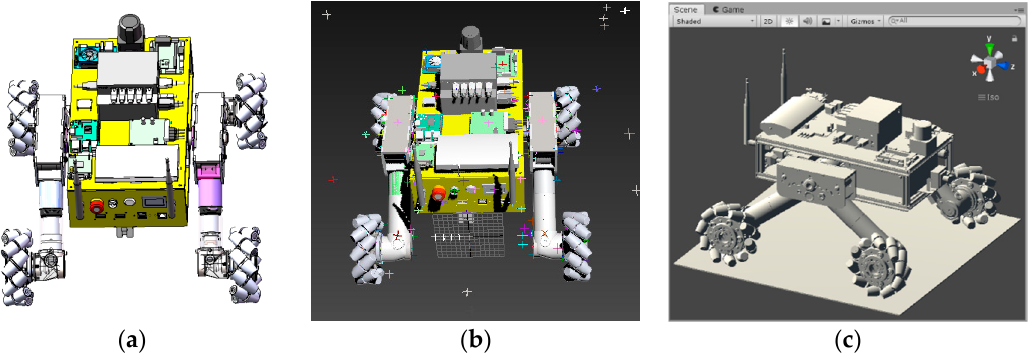
Figure 24. Three-dimensional model of the robot imported from SolidWorks into Unity3D: ( a ) 3D model built in SolidWorks; ( b ) 3D model in 3ds Max; ( c ) 3D model in Unity3D.